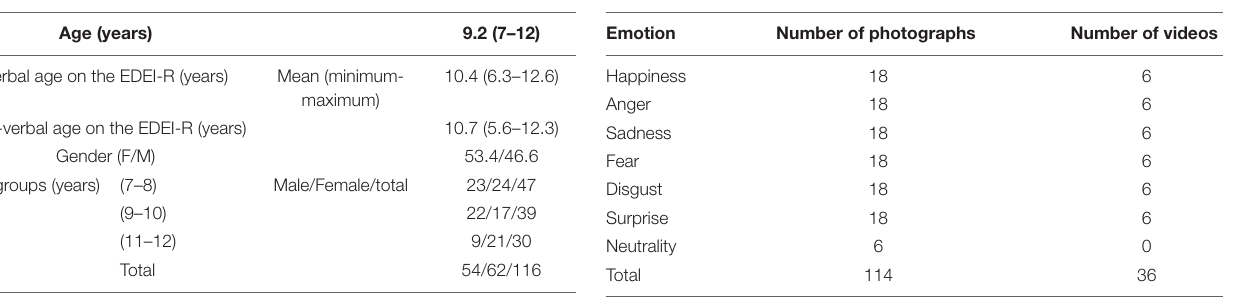
TABLE 1 | Sociodemographic characteristics of the final sample. TABLE 2 | Repartition of the number of photos and videos per